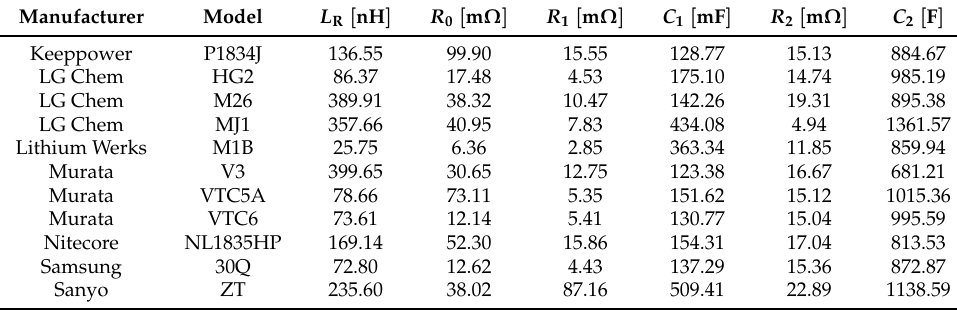
Table 4. Estimated battery parameters for the two- RC -pair model.